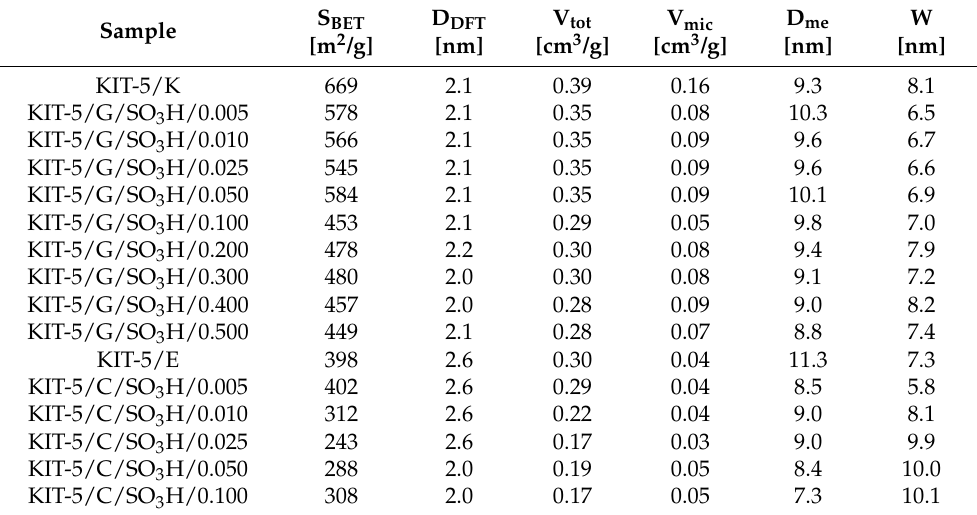
Table 2. Textural parameters of KIT-5 type materials modified with sulfonic groups introduced by grafting or